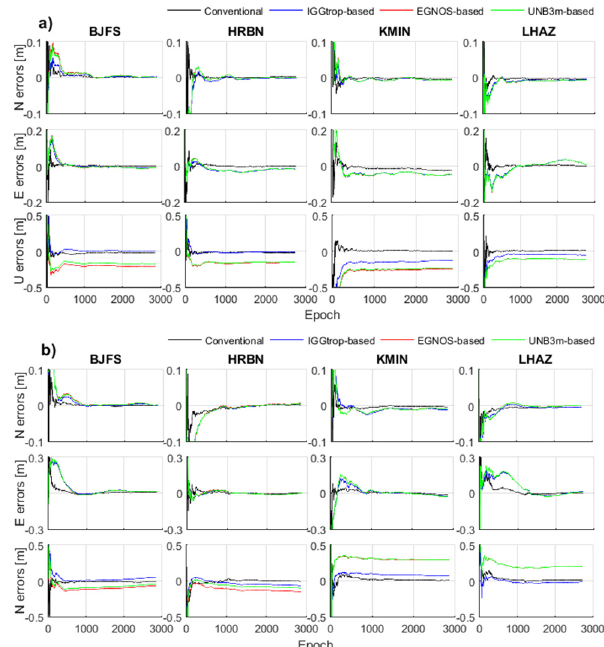
Figure 6. Positioning errors of the conventional PPP and three model-based PPP (IGGtrop-based, EGNOS-based, UNB3m-based) at stations of BJFS, HRBN, KMIN and LHAZ, and the epoch interval is 30 seconds, the DOY are 28 ( a ) and 200 ( b ) in 2012.